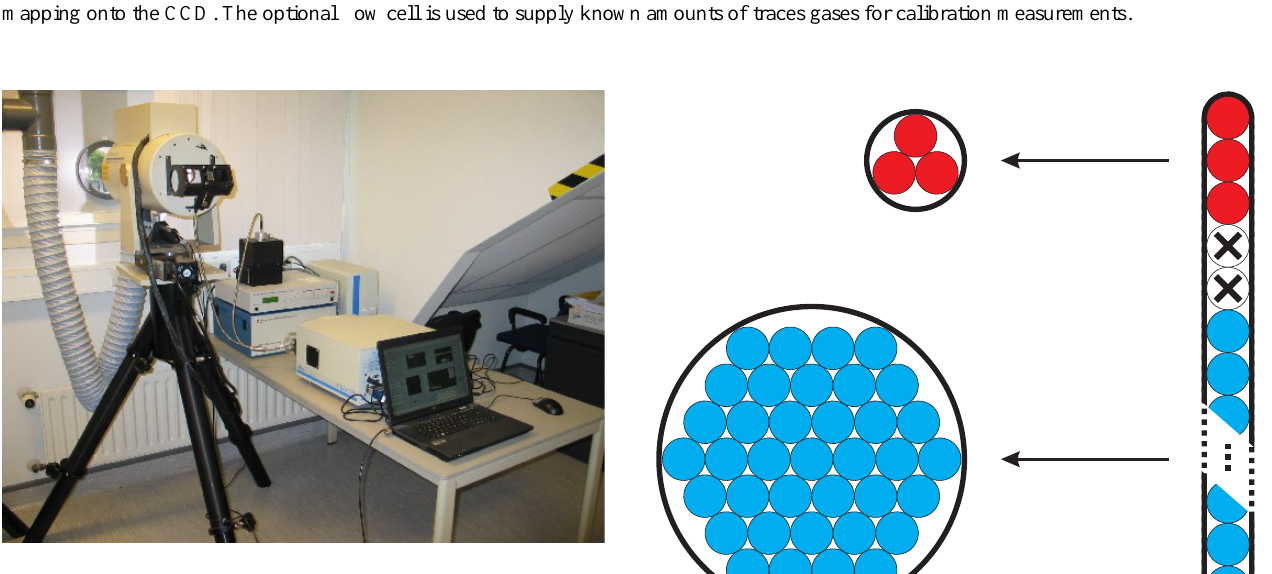
Fig. 3. Photograph of the RIVM DOAS instrument. Fig. 4. The optical fiber bundle is a spot/spot to slit line bundle assembly. The end going to the spectrograph consists of 47 fibers formatted into a slit line. The other end of the bundle is divided into two legs. One leg contains the top 3 fibers from the slit line formatted into a spot. This end leads to the zinc lamp. The next 2 fibers from the slit line are intentionally dark (dead). The other leg consists of the remaining 42 fibers formatted into a spot. The light of the telescope is focussed on this spot.